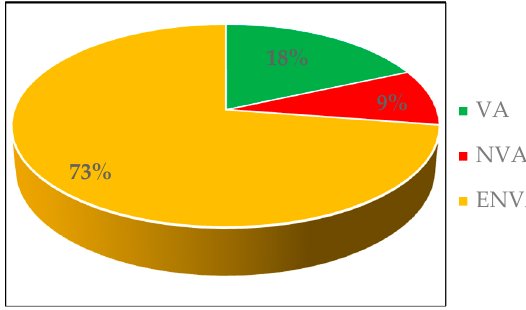
Figure 3. Summary of the VSM data of the process “installation of an aerated concrete block”.